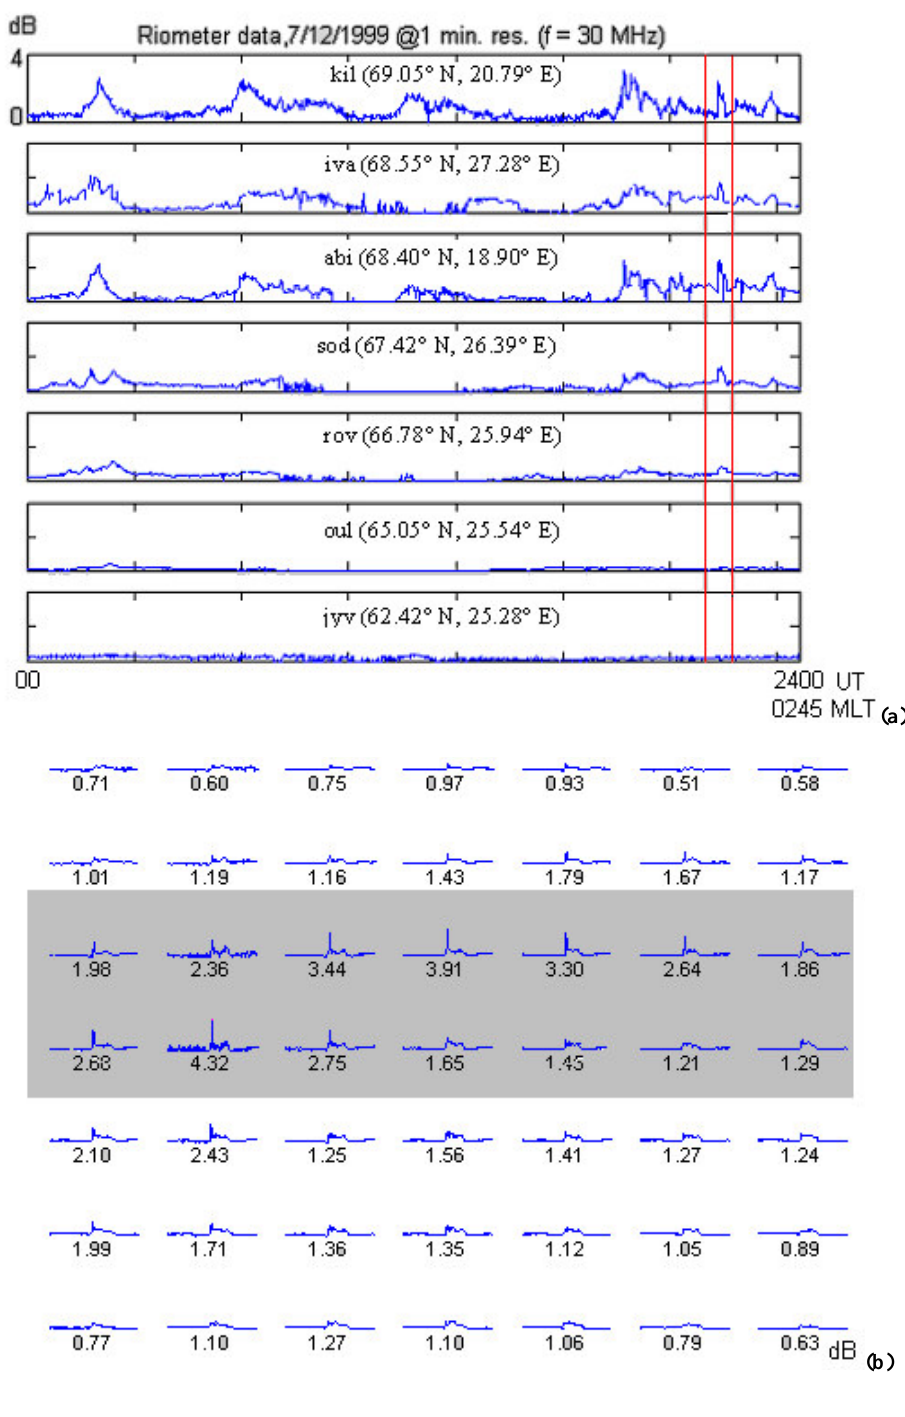
Fig. 10. (a) Occurrence of spikes in SGO riometer chain for day 7 December 1999 00:00–24:00 UT (02:45 MLT) at 1-min resolution. Geo- graphic latitude and longitude of stations are mentioned in brackets. Data is scaled between 0 and 4dB. Red lines highlight the spikes occurred between 21:00–22:00 UT(23:45-00:45 MLT). (b) IRIS field of view for event 7 December 1999 21:00–22:00 UT (23:45–00:45 MLT). Data are at 10-s resolution. Numbers are the peak of absorption in dB in each narrow-beam. Grey area highlights narrow-beams with the highest